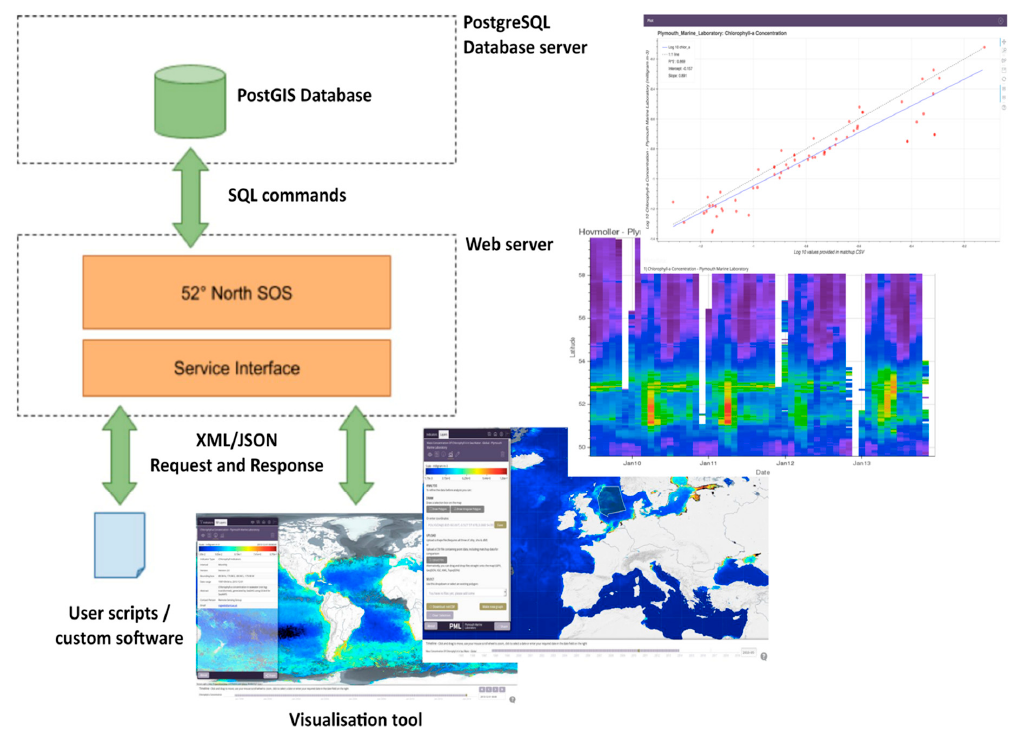
Figure 23. The architecture and functionality of the FRM4SOC field intercomparison database. Graphs and plots are included only as examples of the functionality of the visualisation tool.